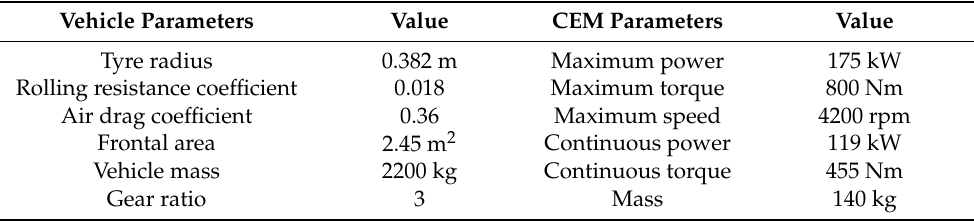
Table 1. Parameters of the